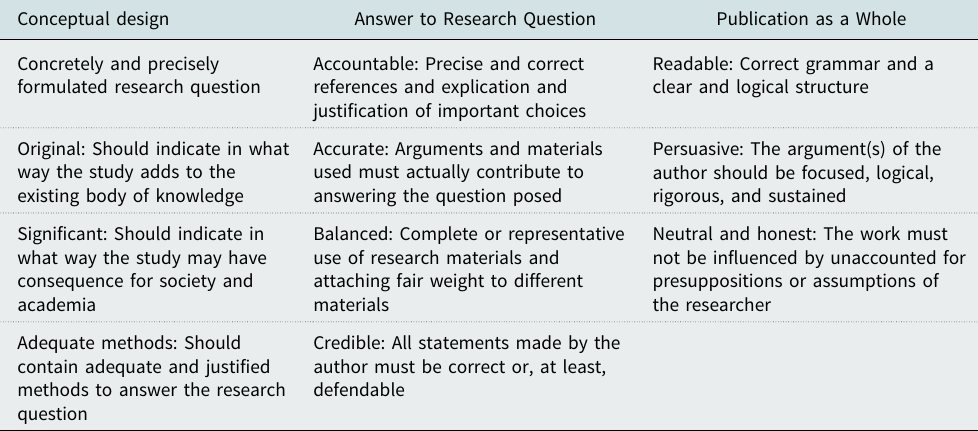
Table 1: Overview of Quality Standards Conceptual design Answer to Research Question Publication as a Whole Concretely and precisely formulated research